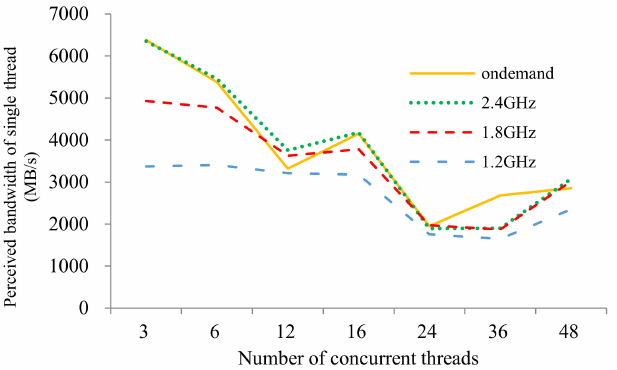
Figure 5. Average perceived bandwidth of single thread with array size = 4 GB (MB/s) on server